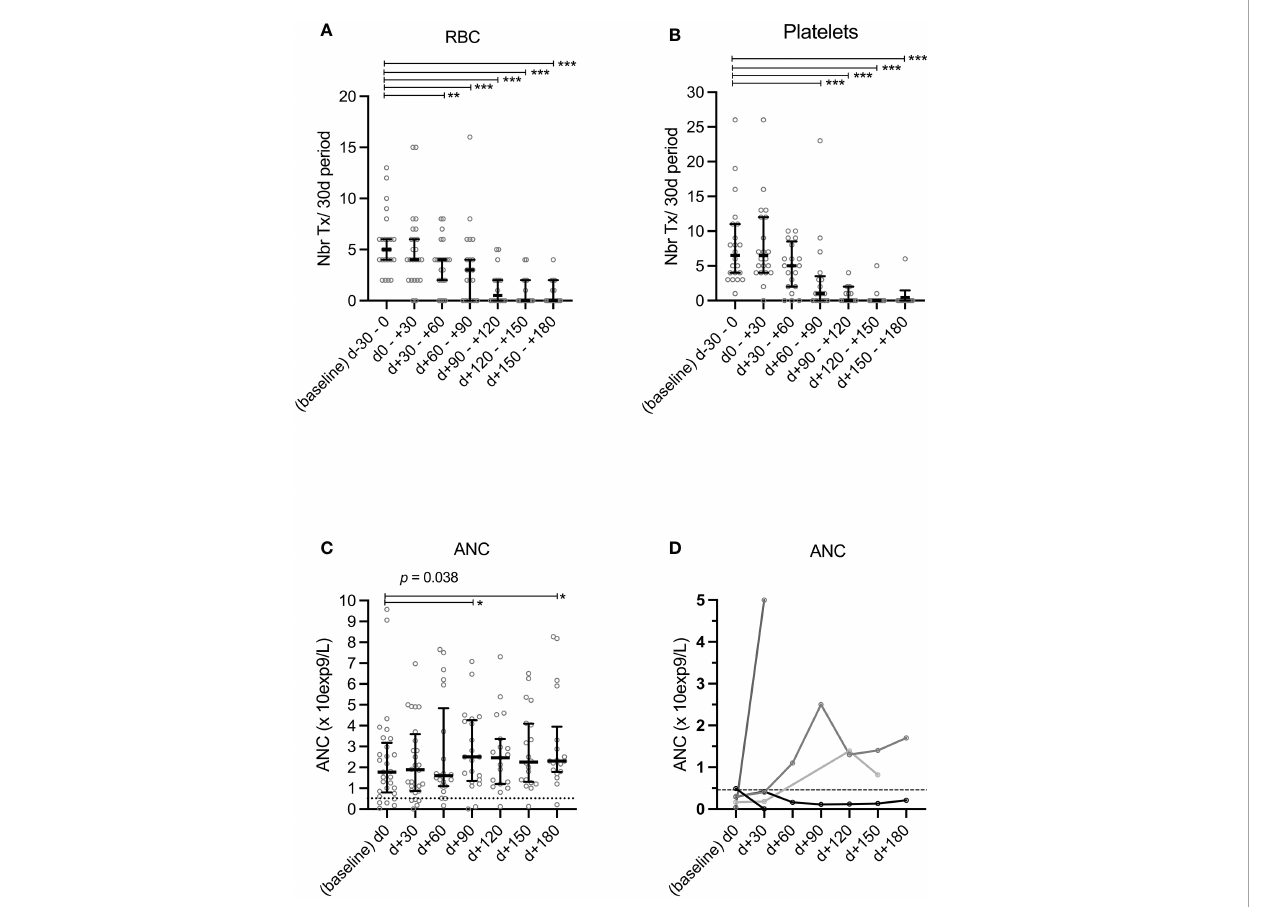
FIGURE 2 Prospective monitoring of transfusion requirements and ANC after MSC therapy. Numbers of transfused red blood cell (RBC) (A) and platelet (B) concentrates over 30-day periods and circulating absolute neutrophil counts (ANC) (C, D) were prospectively recorded from baseline and up to 180 days after MSC infusion. Data were censored at relapse of hematological malignancy or second transplantation. Among the 5 patients who had severe neutropenia by the time of MSC therapy (D) , 1 received a second alloHCT on d+33 after MSC for persistent PGF (NoR at d+30); 1 recovered an ANC > 1x10 9 /L at d+30 then relapsed from the malignant hematological pathology, 2 recovered an ANC > 1x10 9 /L at d90-120 and 1 retained persistent severe neutropenia. *p<0.05, **p<0.01, ***p<0.001 (Wilcoxon rank sum test). ANC refers to absolute neutrophil counts; Nbr Tx, number of transfusions; RBC, red blood cells.